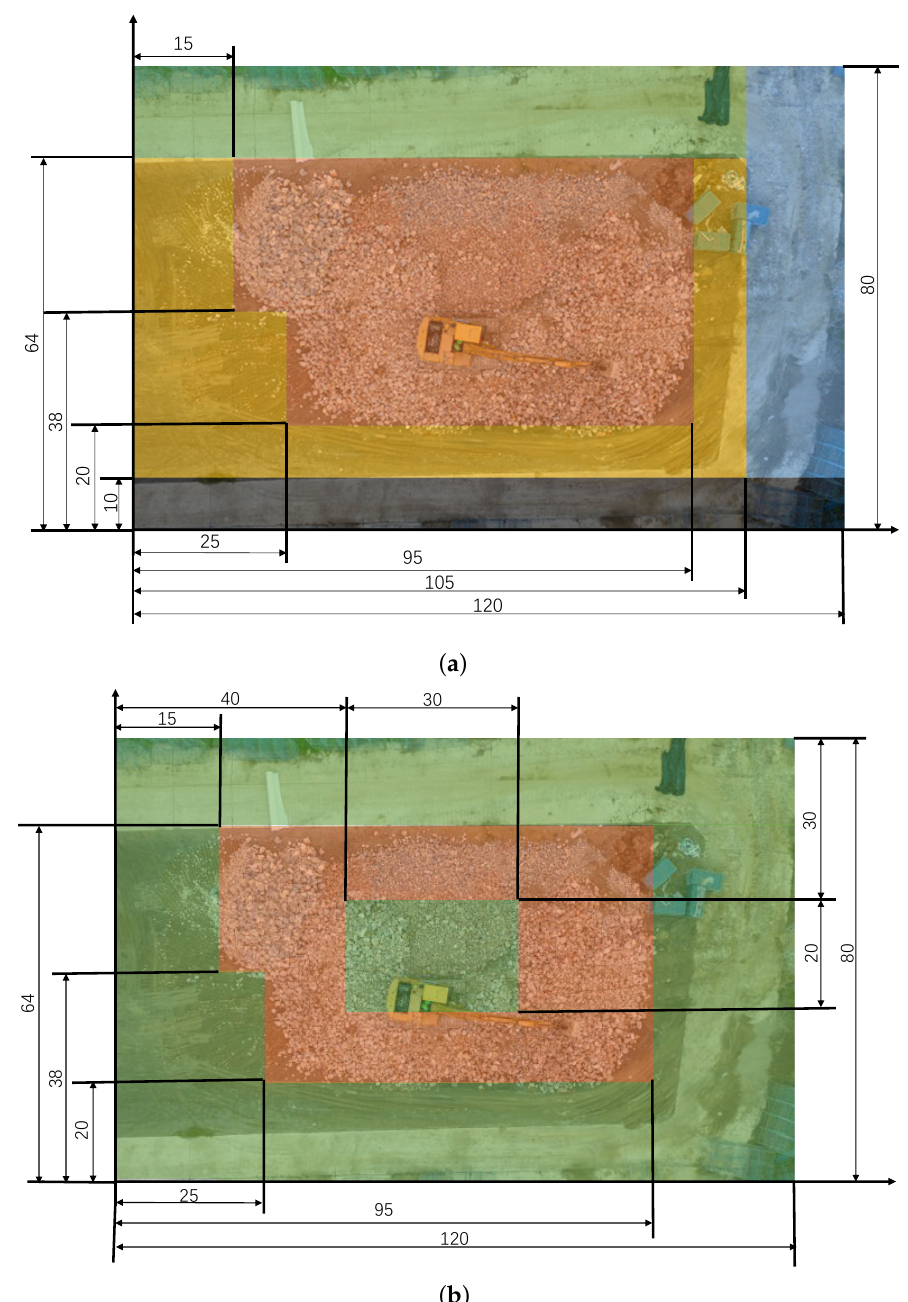
Figure 6. The ground truth map with dimensions. The simulation environment we used in Gazebo was modeled based on a real construction site, and the parameters are selected according to material characteristics. Since simulating a small construction site may cause system error and thus lack plau- sibility, we augmented this real construction site’s dimensions in Gazebo. ( a ) Example construction site divided into five areas according to different ground resistances; ( b ) Example construction site divided into two areas according to different